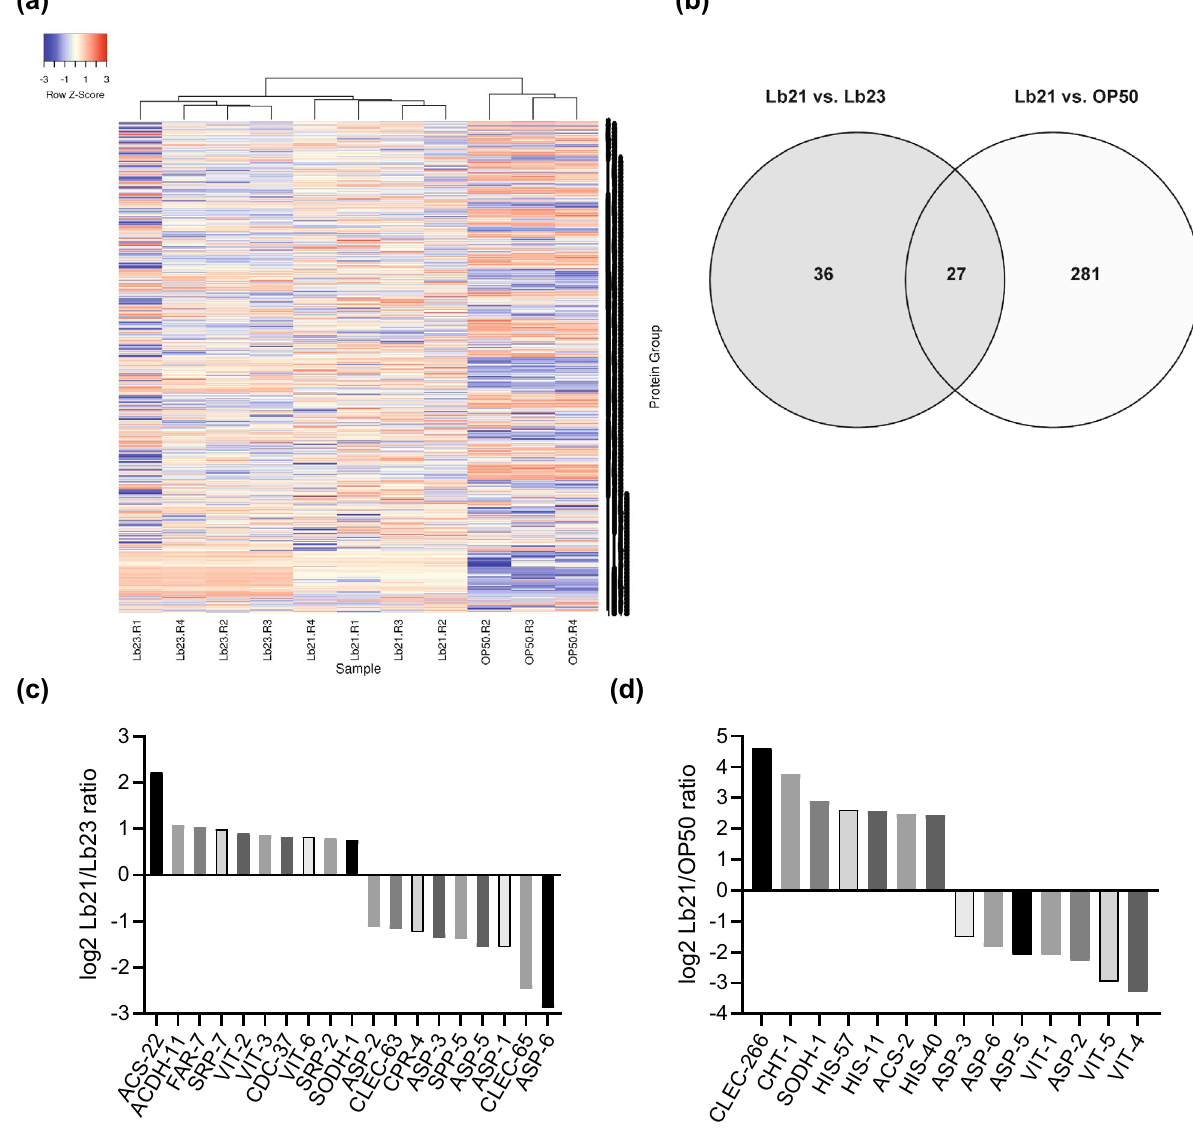
Figure 4. C. elegans proteome response to Lb21, Lb23 and OP50. ( a ) Heat map showing hierarchical clustering of the C. elegans proteome response to Lb21, Lb23 and OP50, based on log(2) transformed intensities of all quantifiable proteins. ( b ) Venn diagram showing the number of proteins with regulated abundance when two of the three food sources are compared pairwise. A total of 474 proteins showed regulated abundance in either of the comparisons. ( c ) A subset of regulated proteins between Lb21 and Lb23. ( d ) A subset of regulated proteins between Lb21 and OP50. See Table S3 for list of all regulated